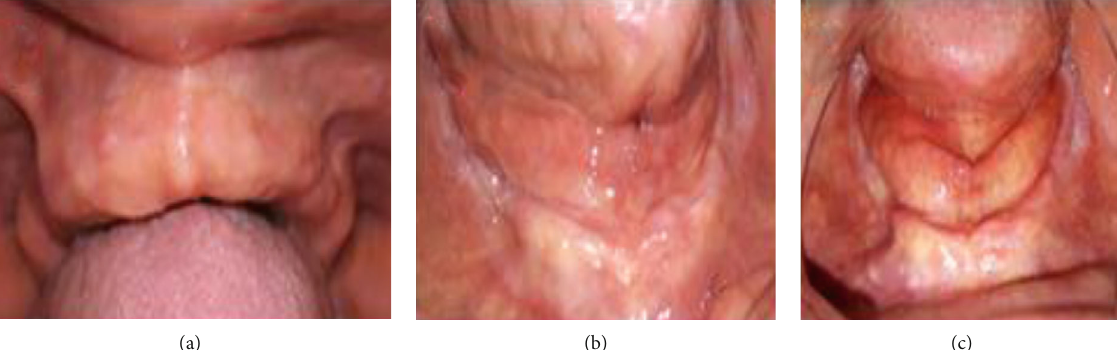
Figure 5: Regression of the in fl ammation of the maxillary and mandibular fi bromucosa after occlusal conditioning treatment: (a, b) one week and (c) two